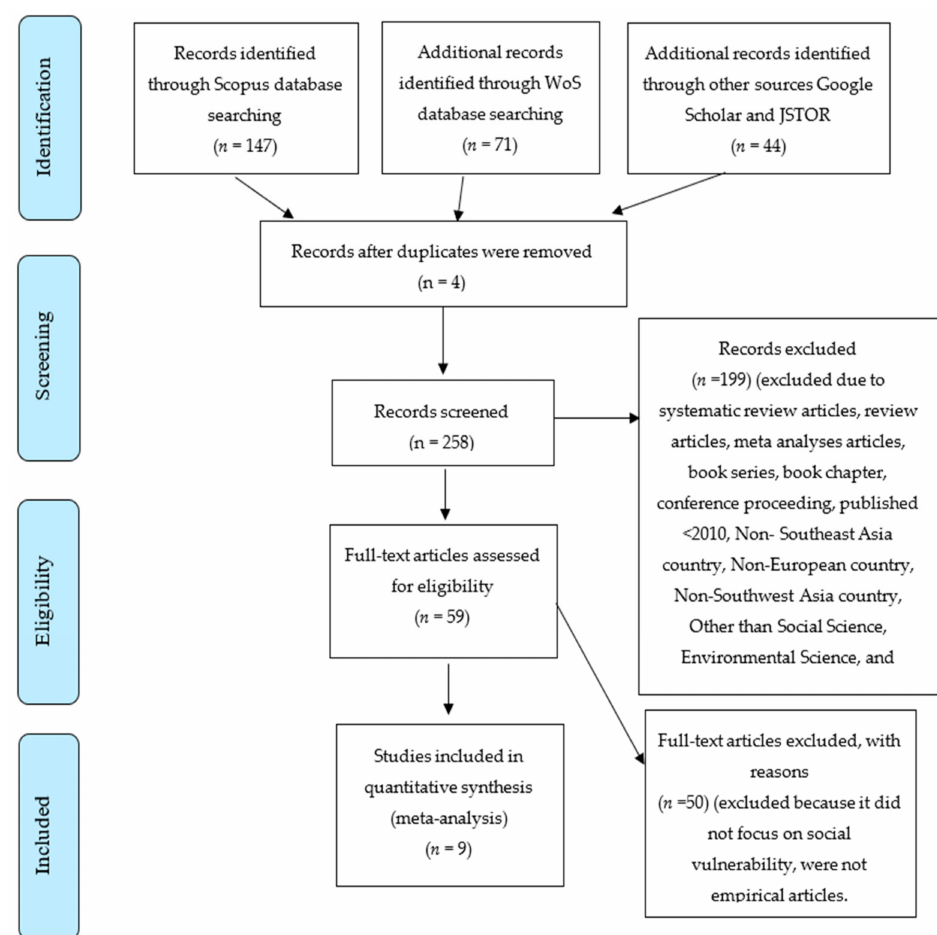
Figure 1. Literature searches based on Preferred Reporting Items for Systematic Reviews and Meta- Analyses (PRISMA) is guidelines (adapted from